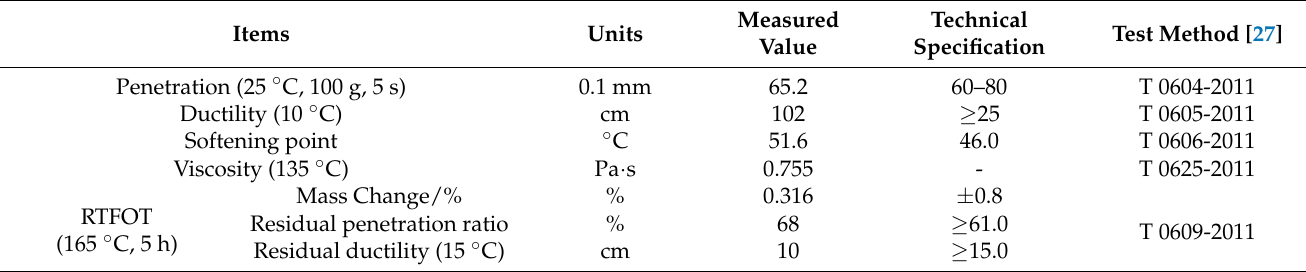
Table 1. Performance index of 70# BA.